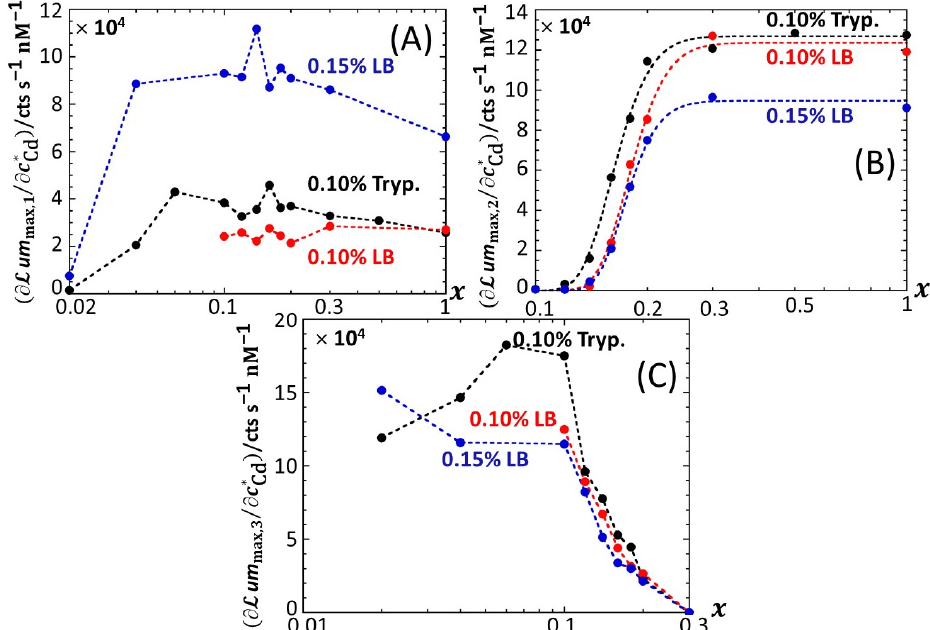
Figure 7. Slopes associated with the linear regressions of ℒ um max,1 ( A ), ℒ um max,2 ( B ) and ℒ um max,3 ( C ) for the various x -conditions tested in 0.1% tryptone, 0.1% LB and 0.15% LB media (specified). (+) symbols: experimental data. Lines: guides for the eyes. Data in this figure originate from those given in Figures 2, S2 and S3 (corrected for the corresponding reference measured at 0 nM Cd concentration).